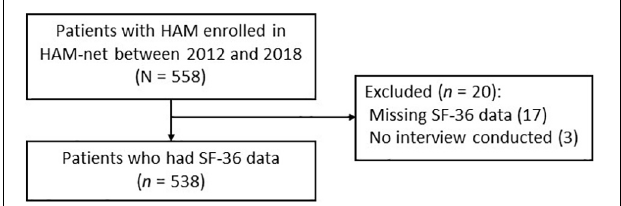
FIGURE 1 | Study flow chart. HAM, HTLV-1-associated myelopathy.